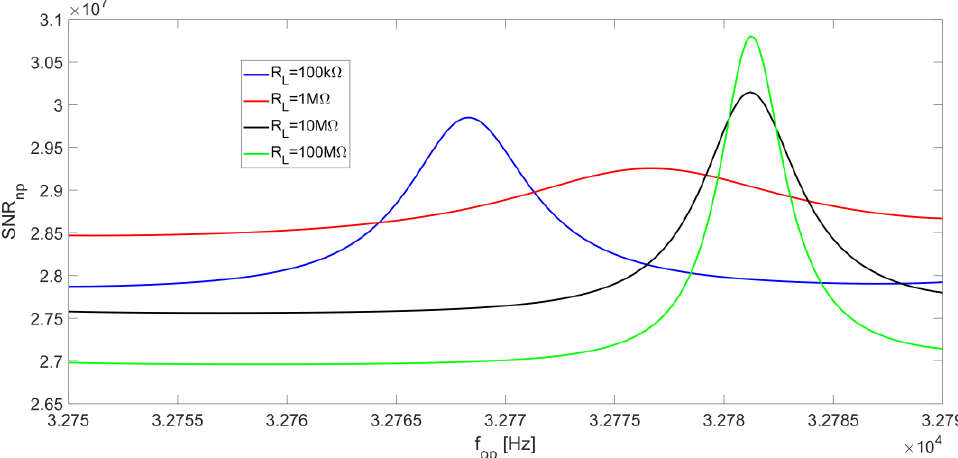
Figure 14. R P noise contribution to the SNR n at the LIA output as a function of the operating frequency, for different values of R L and at a low-pass filter bandwidth of BW = 0.5 Hz. As for the term SNR nL , its behavior as a function of f op is strongly affected by the minimum of the noise spectral density S nL at f S . This effect prevails over the peak value of the signal, which moves towards f P for increasing values of R L , resulting in a local maximum point on SNR nL which is always located at the series-resonant frequency f S for any value of R L . Figure 15 shows the behavior of SNR nL as a function of the operating frequency for different R L values.